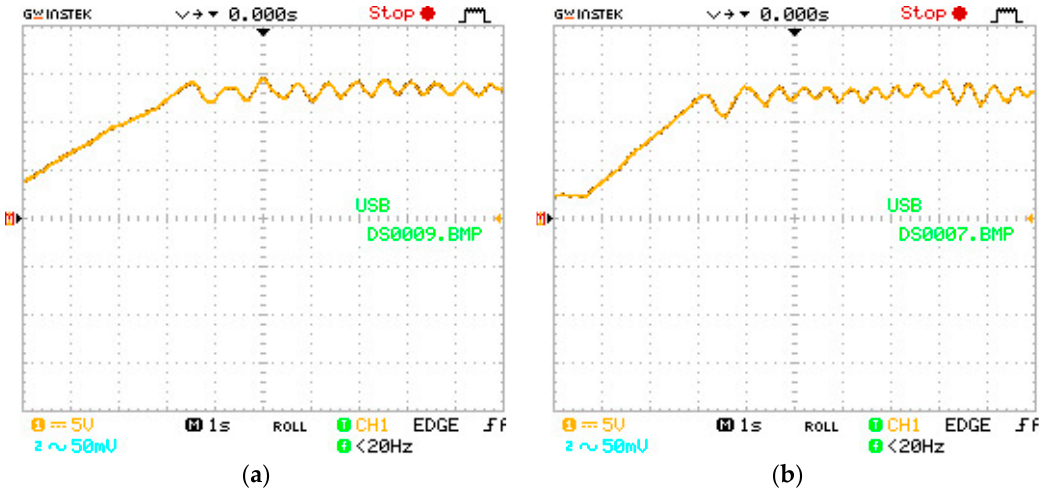
Figure 18. ( a ) PV Voltage and ( b ) PV Power of conventional P&O algorithm.